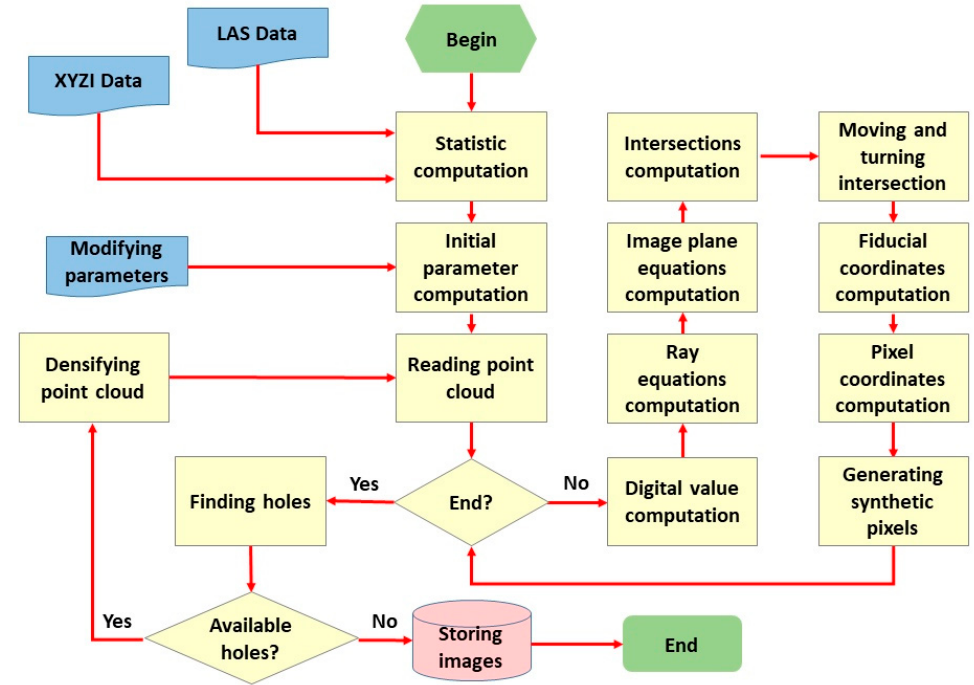
Figure 1. Block diagram for the generation of synthetic images.